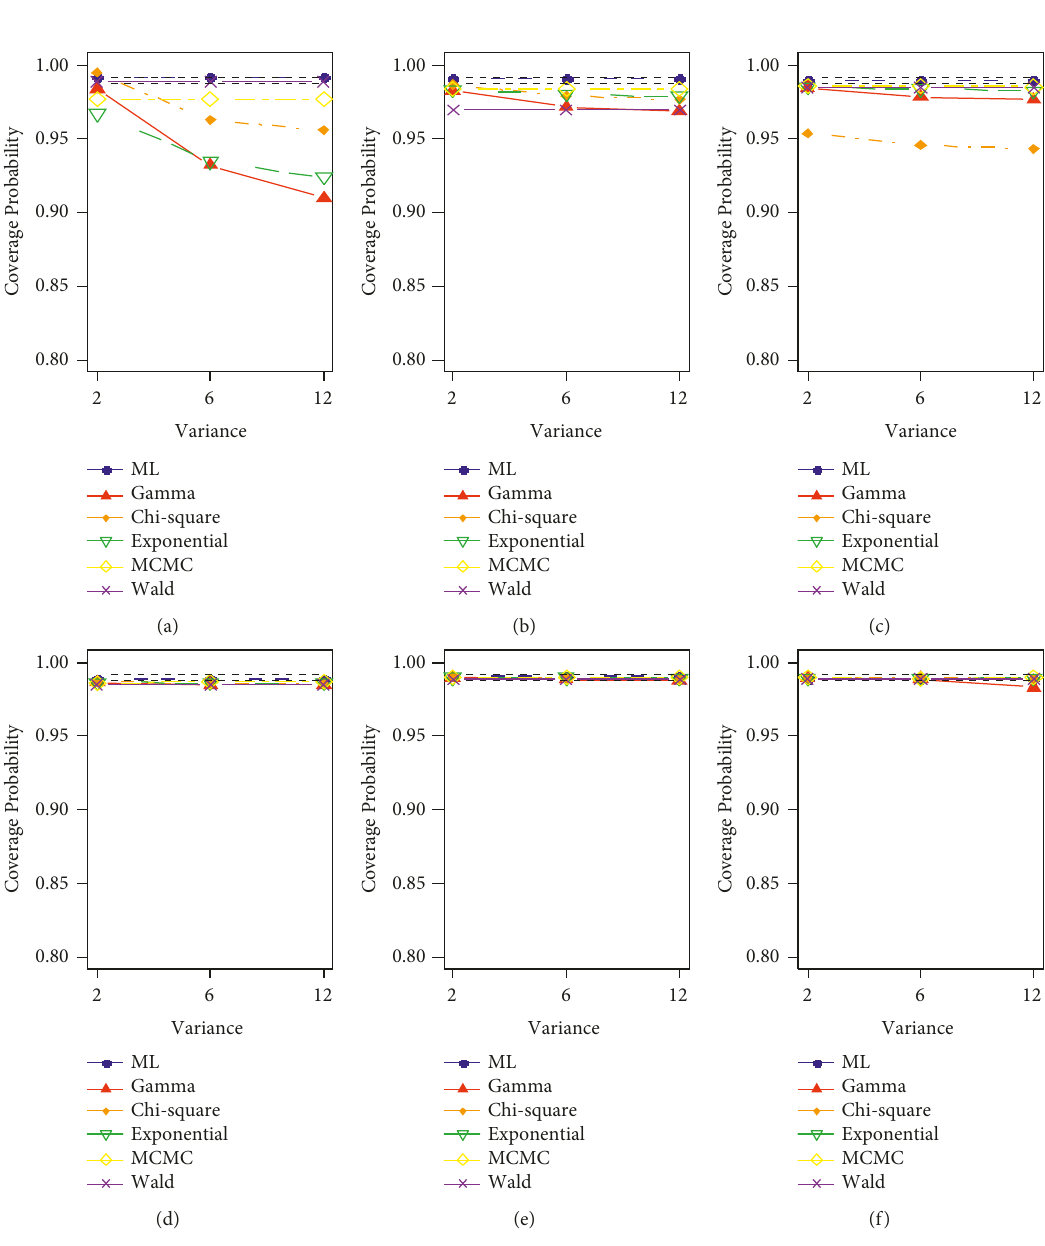
Figure 8: The trend of CP for all methods varies by variance at 99% confidence interval. (a) n � 10. (b) n � 50. (c) n � 100. (d) n � 300. (e) n � 500. (f) n �